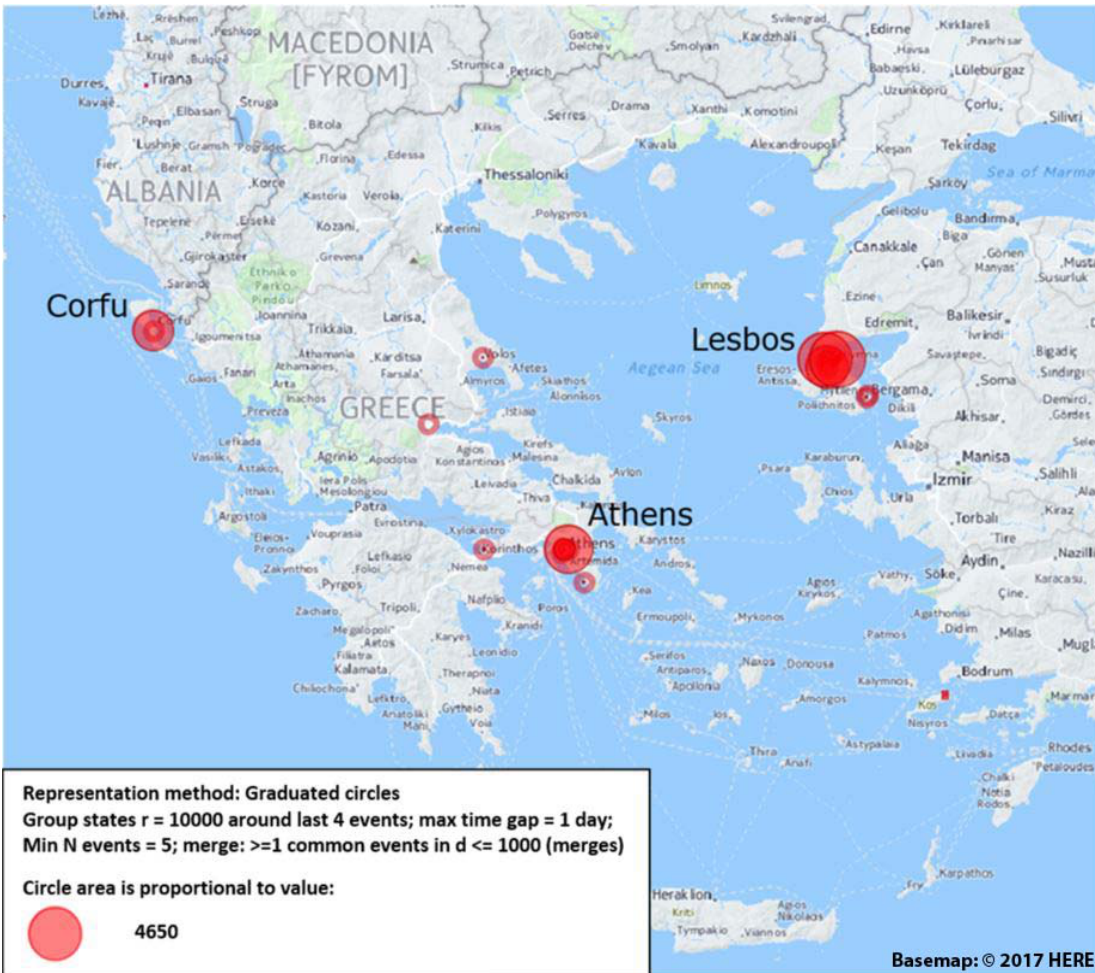
Figure 16. Result of distance-bounded event clustering for Greece.